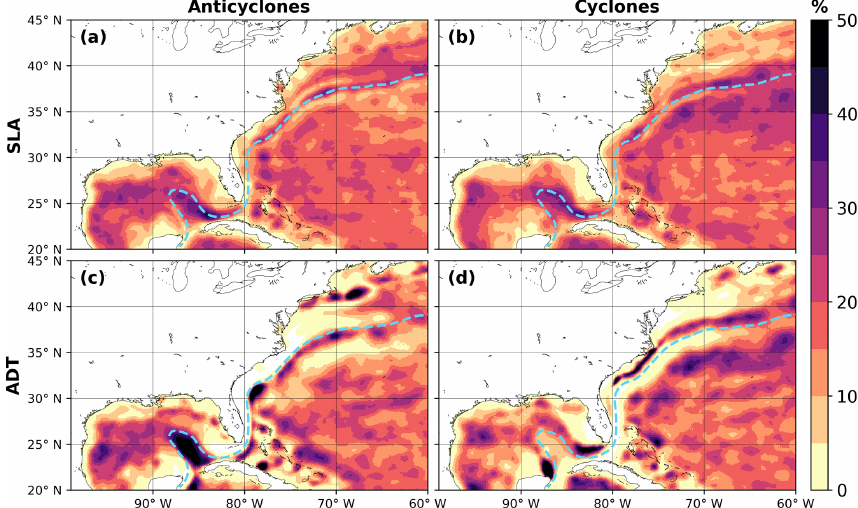
Figure 6. Percentage of time spent by each pixel of 0 . 1 ◦ × 0 . 1 ◦ within anticyclones detected in (a) SLA and (c) ADT maps and within cyclones detected in (b) SLA and (d) ADT maps. The dashed blue line follows the velocity maximum of the